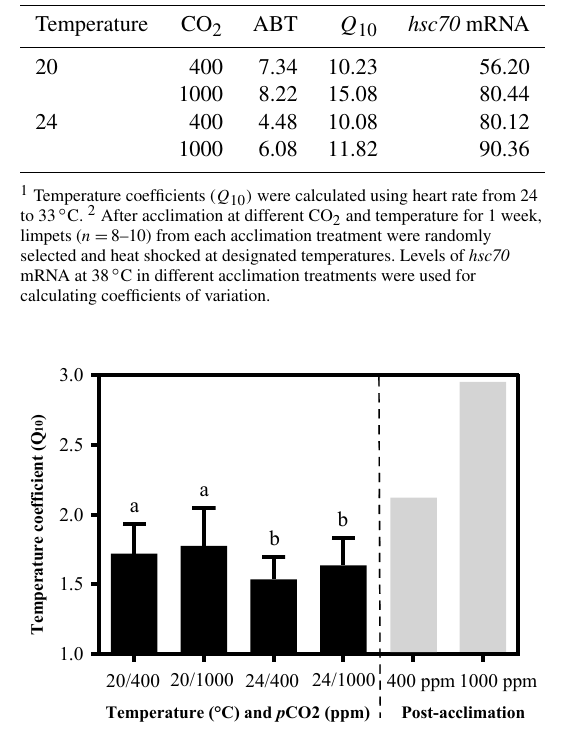
Figure 2. Temperature coefficients ( Q 10 ) of limpets acclimated at different temperatures (20 or 24 ◦ C) and CO 2 concentrations (400 or 1000ppm). The temperature coefficient ( Q 10 ) values were cal- culated for all limpets using heart rate data from 24 to 33 ◦ C. Post- acclimation temperature sensitivity was calculated among individ- uals acclimated at 20 and 24 ◦ C (grey bars; sensu Seebacher et al., 2015) for each CO 2 concentration, where higher thermal sensitiv- ity indicates less acclimation to thermal stress. The calculation of post-acclimation Q 10 is carried out for the mean response of all in- dividuals as the same individuals are not used at each acclimation temperature. Therefore, it is not possible to calculate an estimate of variation or error for post-acclimation Q 10 . Different letters repre- sent significant differences in the Q 10 among different acclimation